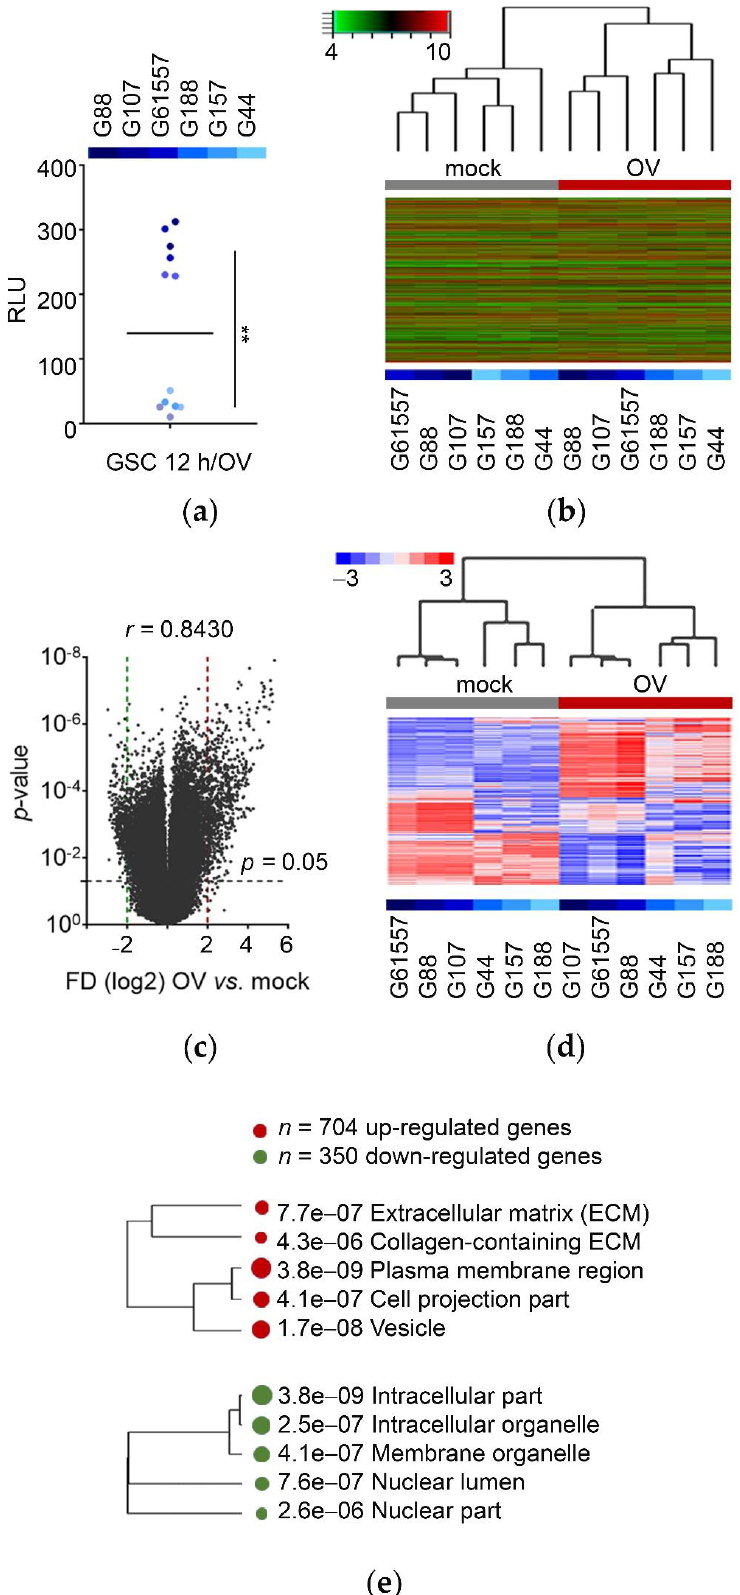
Figure 1. Oncolytic virus (OV) infection alters the transcriptome of patient-derived glioblastoma stem-like cells (GSCs) toward extracellular mode. ( a ) GSCs displayed variable sensitivity to OV infection. GSCs ( n = 6, in duplicates, see color